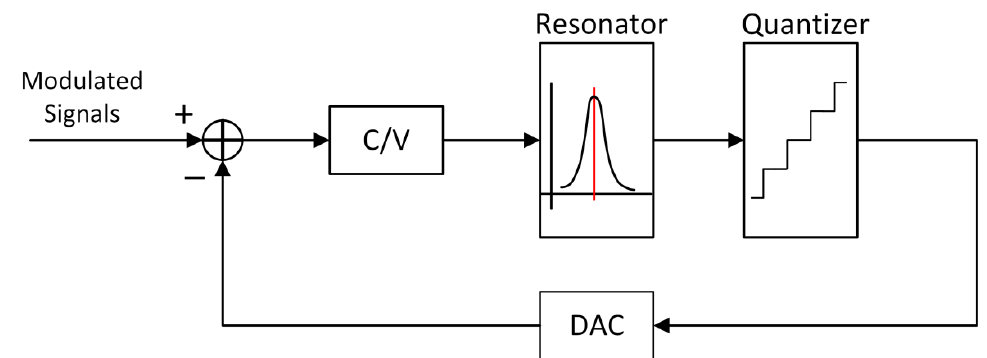
Figure 3. Schematic diagram of the BPSDM circuit.